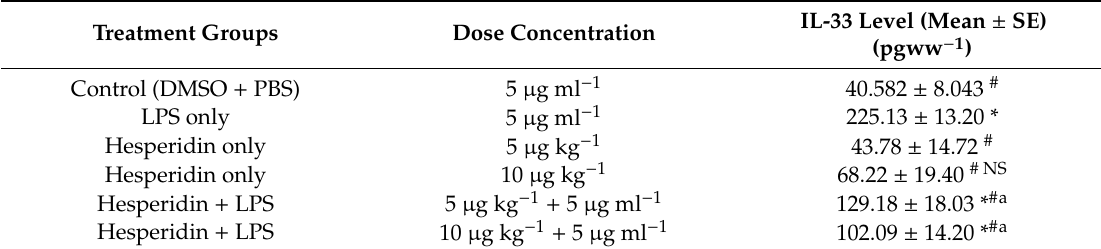
Table 1. IL-33 level in spleen homogenate of mice injected hesperidin for five days and treated with or without lipopolysaccharide (LPS). Experiment was performed in duplicate.